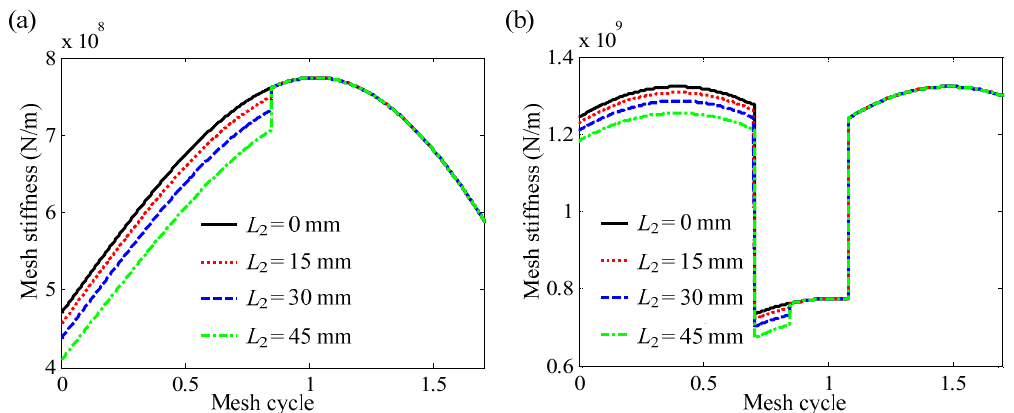
Figure 6. Effects of surface crack width on meshing stiffness: ( a ) single-tooth pair, ( b ) double-tooth pairs. The effects of the crack depth ( D ) on the meshing stiffness of the single-tooth pair and double-tooth pair are analyzed when setting the surface crack parameters as L 1 = 2 mm, L 2 = 40 mm, D = 1, 2, 3 mm and x 1 = 2 mm. We can find in Figure 7 that the reduction in the magnitude of the meshing stiffness is gradually enlarged when the crack depth increases, while the areas where the mesh stiffness decreases remain the same. The maximum ratios of the stiffness reduction of single and double tooth pairs are 10.8% and 7.2%, respectively.